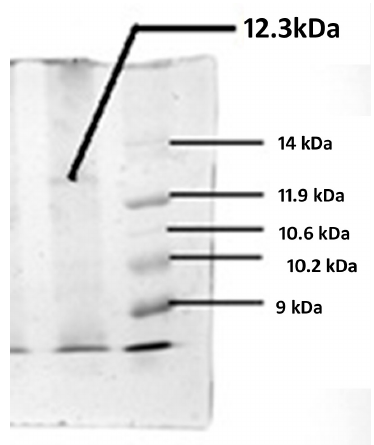
Fig. 12. Separation of bacteriocin by tricine-SDS-PAGE and stained with Coomassie brilliant blue R 250. Lane -1: The protein band with antimicrobial activity against L. monocytogenes and A. baumannii .. Lane-2: Protein molecular weight markers in low range (9-14